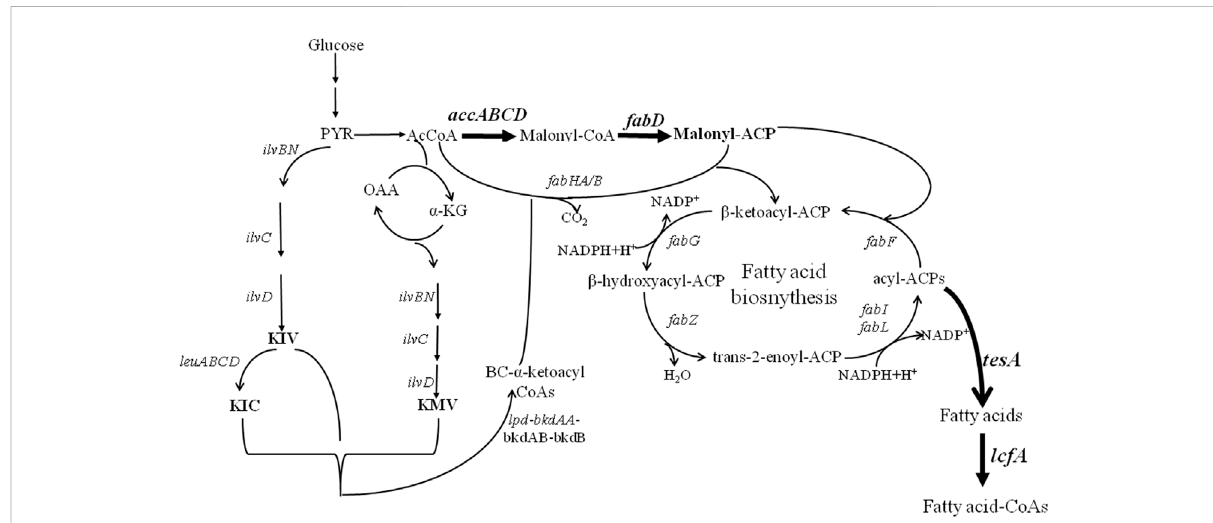
FIGURE 1 Metabolic engineering of fatty acid synthesis pathways for enhanced production of iturin